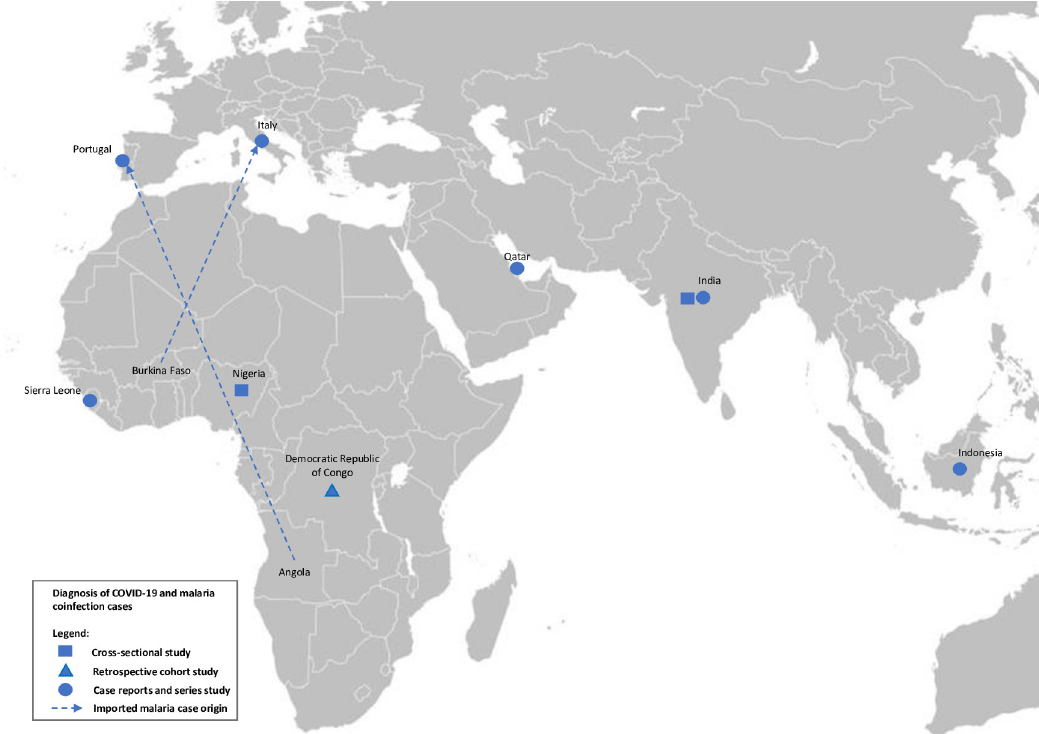
Fig 2. Global distribution of Plasmodium spp. infection among patients with COVID-19 (blue color). The map was created from the map template available at https://commons.wikimedia.org/wiki/Atlas_of_the_world.